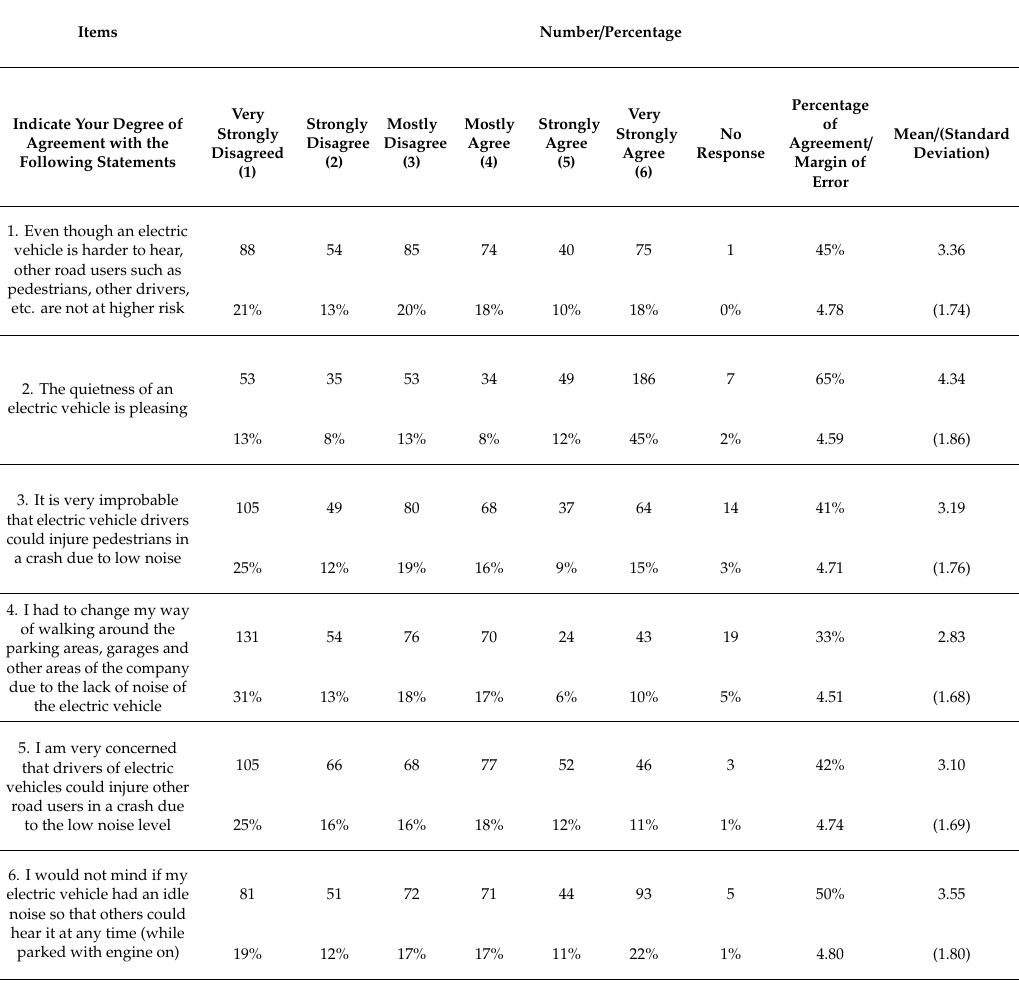
Table A1. Results of workers’ responses to the items related to the perception of risk due to the low noise of EVs and